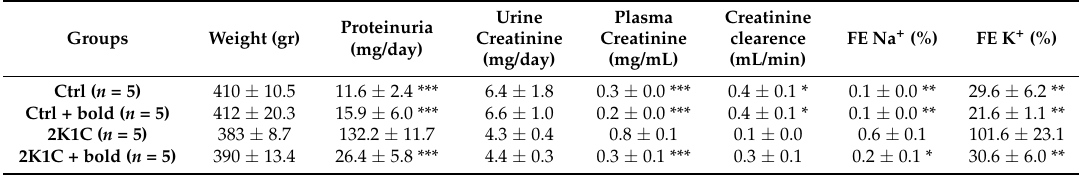
Table 1. Values for proteinuria, creatininuria, creatininemia, creatinine clearance, and fractional excretion (FE) for Na + and K + in the four groups. Boldine was administered by gavage at doses of 50 mg/kg during six weeks after hypertension was established in 2K1C rats (pressure ≥ 180 mmHg). Samples of urine and plasma were obtained. Protein and creatinine were measured to assess renal function; the fractional excretion of sodium and potassium (FENa + , FEK + , [%]) was also determined. Data are expressed as mean ± SE. The differences were evaluated by analysis of variance followed by the Tukey post-hoc test. * p < 0.05, ** p < 0.01, *** p < 0.001 vs. 2K1C ( n = 5/all groups).